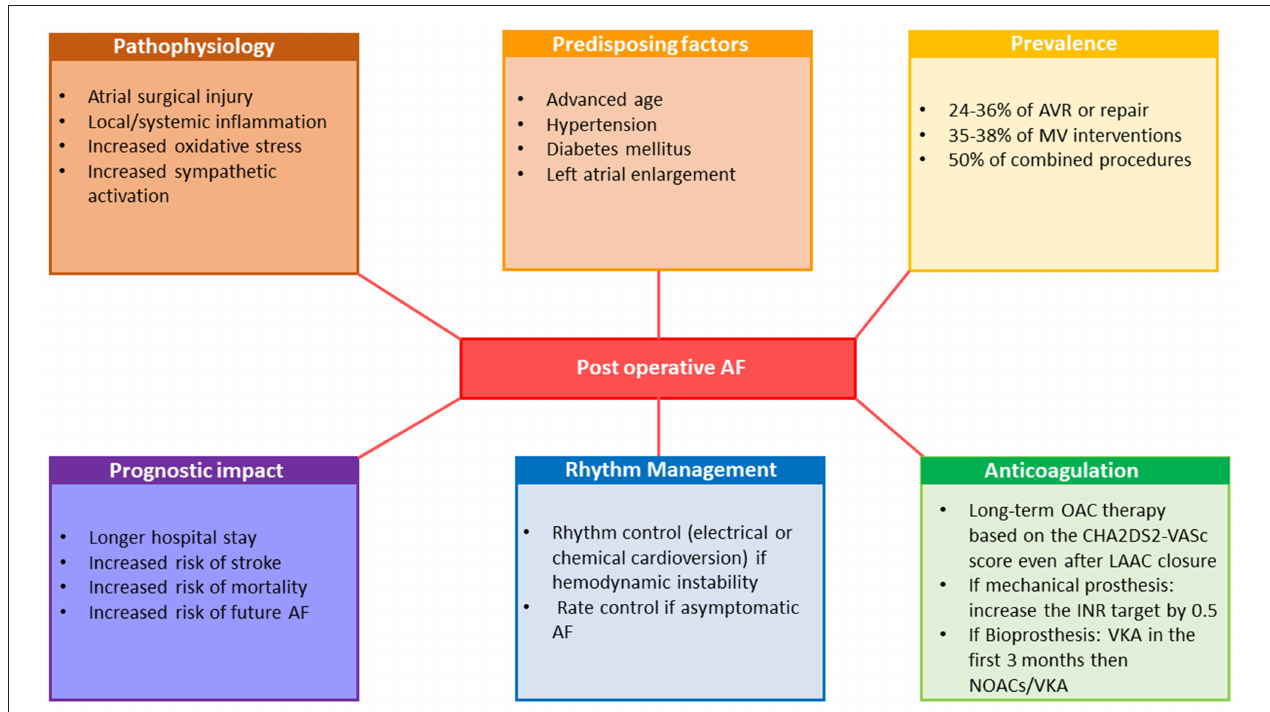
FIGURE 5 | Pathophysiology, prognostic implications and management of postoperative atrial fibrillation. AF, atrial fibrillation; AVR, aortic valve replacement; INR, international normalized ratio; LAAC, left atrial appendage closure; MV, mitral valve; NOAC, non-vitamin K oral anticoagulants; OAC, oral anticoagulation therapy; VKA, vitamin-K